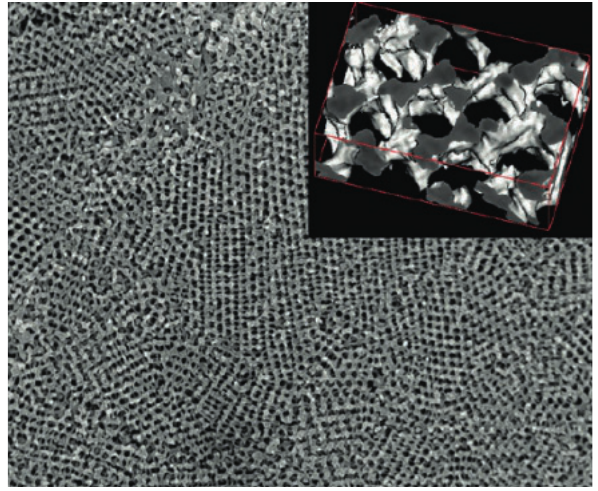
Figure 11. Electron micrograph of silica templated from a copoly- mer material, whose nanostructure (inset) corresponds to a single rod network in Fig. 10. Image courtesy of Hirokazu